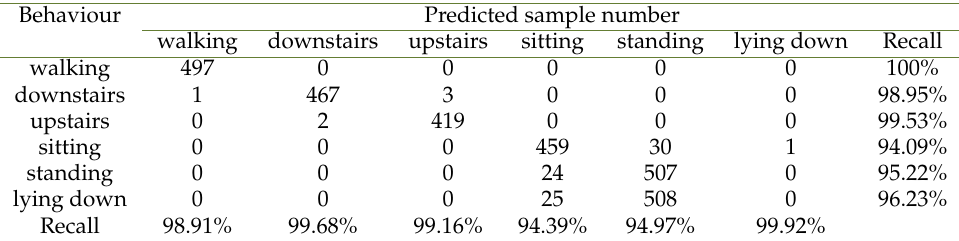
Table 4. HAR data set human behavior recognition confusion matrix.